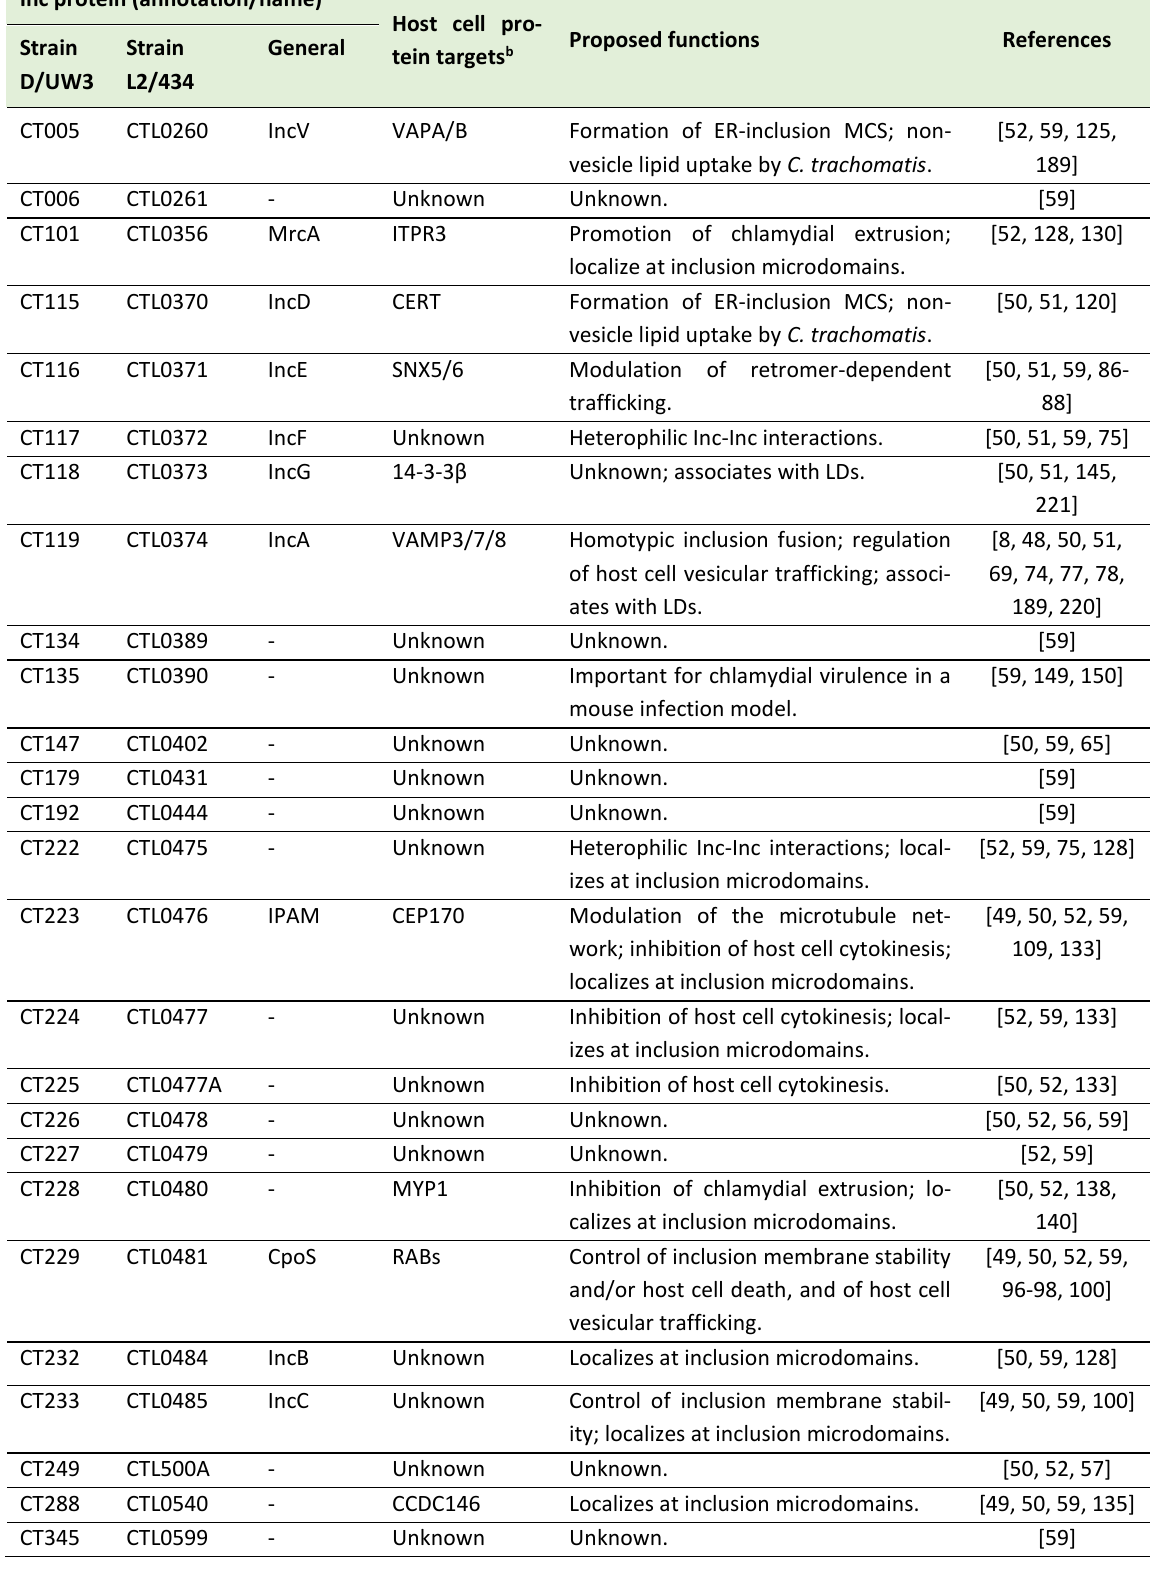
TABLE 1: C. trachomatis known Inc proteins a . Inc protein